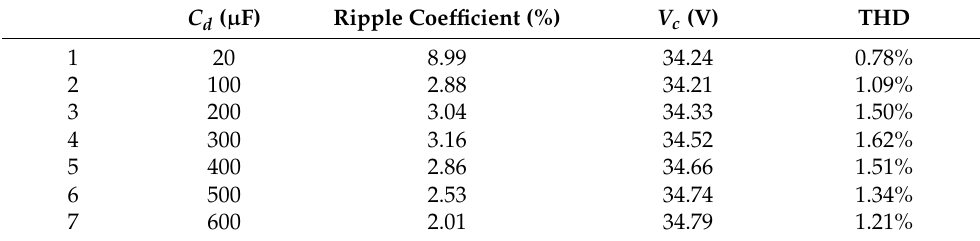
Table 3. Parameters under traditional modulation strategy.